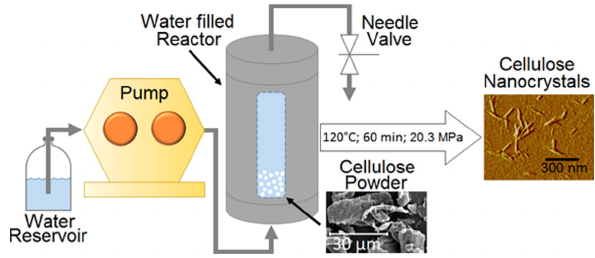
Figure 4: Schematic showing methodology for subcritical water hy- drolysis. Reproduced from [50] Copyright 2015 American Chemical